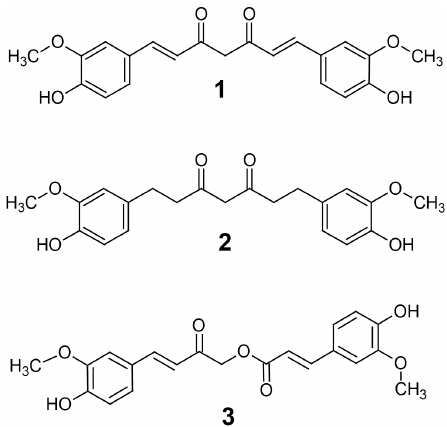
Figure 1. The structures of curcuminoids curcumin ( 1 ), tetrahydrocurcumin (THC) ( 2 ) and calebin-A ( 3 ). Both THC and curcumin are shown in the keto tautomer.